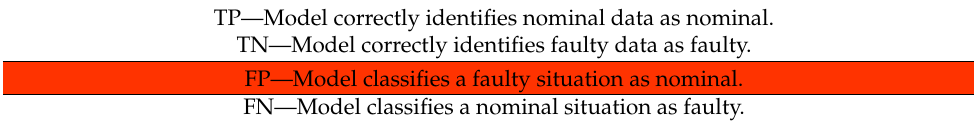
Table 2. Description of the parameters in the confusion matrix. TP—Model correctly identifies nominal data as